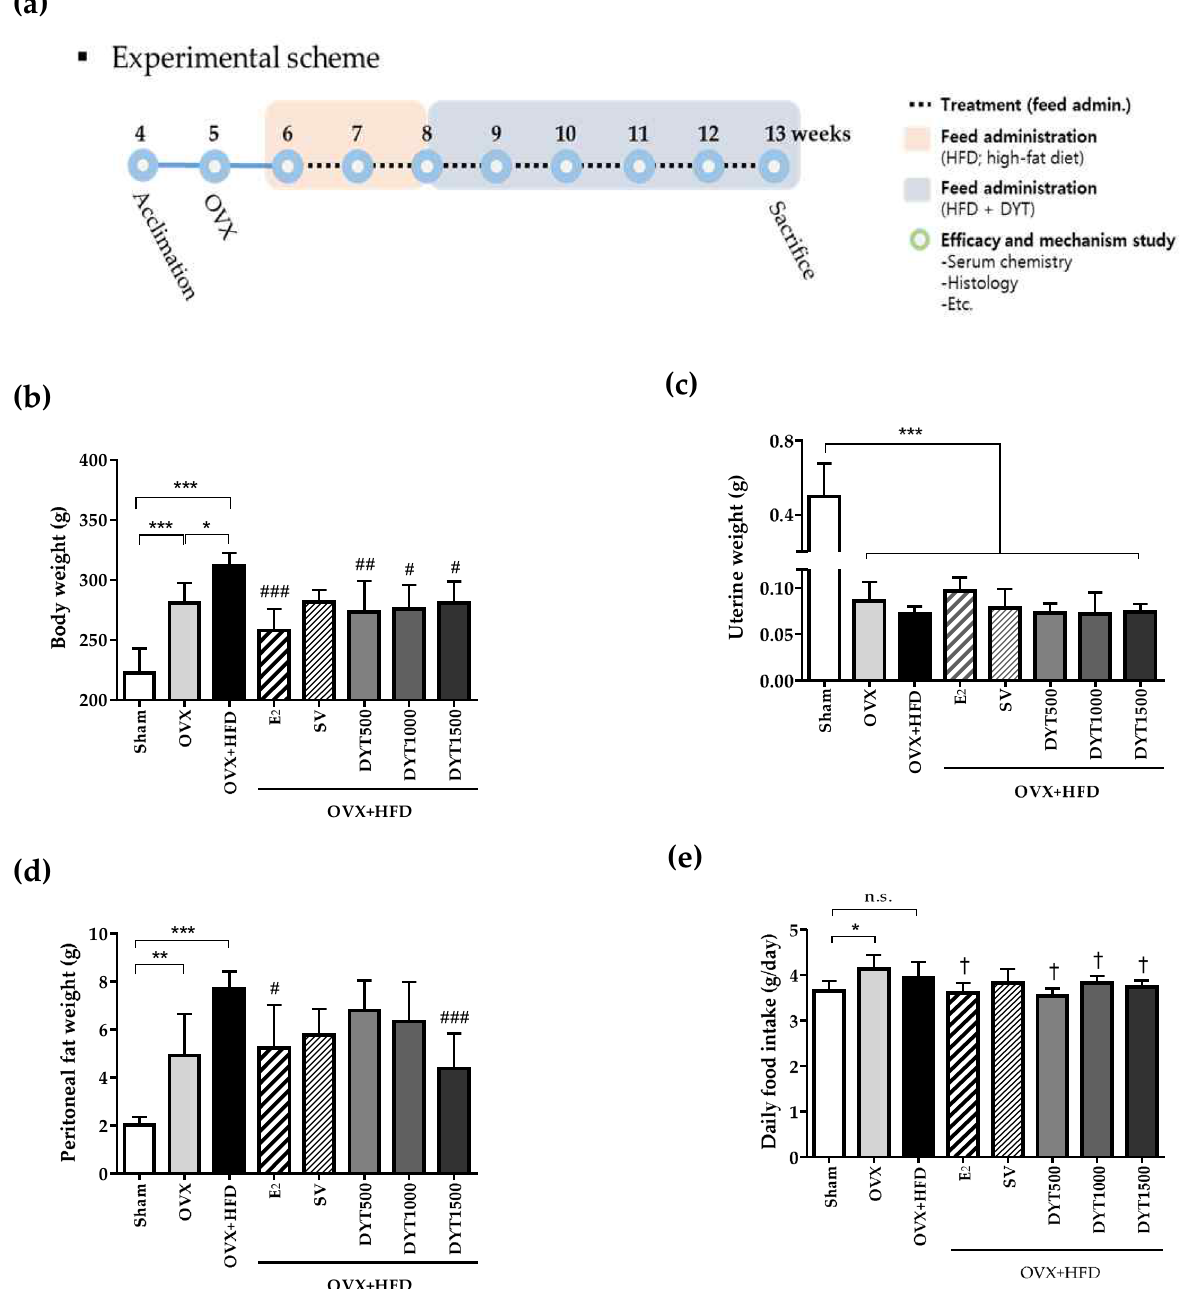
Fig. 4 Effect of DYT in OVX or OVX HFD rat models. A brief overview of the animal model experiments ( a ). Body weight ( b ), uterine weight ( c ), + peritoneal fat weight ( d ), and daily food intake ( e ). Normal diet group: Sham; ovariectomized normal diet group: OVX; ovariectomized